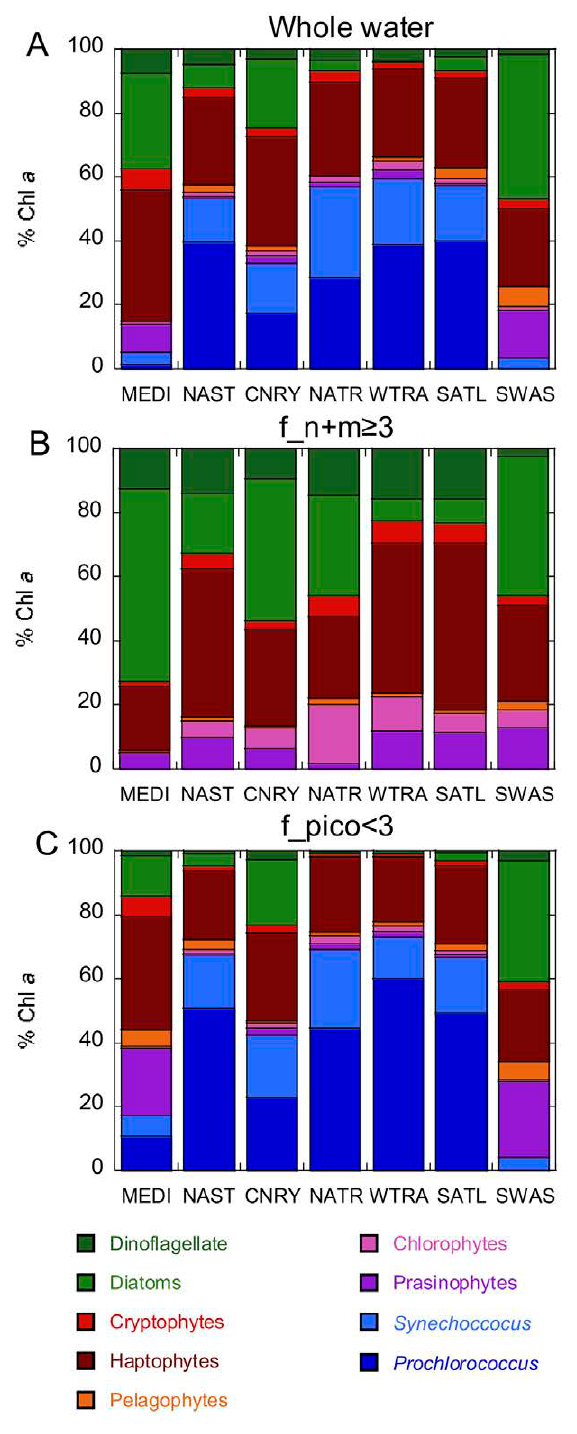
Fig. 7. – Percentage contribution of the chemotaxonomic phyto- plankton groups to Chl a _tot for the whole community (A), the nano+microphytoplankton (f_n+m ≥ 3) size class (B), and the pico- phytoplankton (f_pico<3) size class